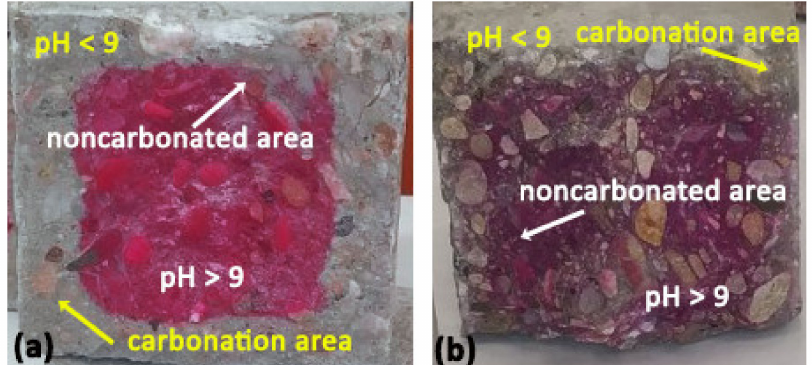
Figure 10. Transverse section of carbonated SCC specimens after 90 days of exposure: ( a ) SCC control and ( b )